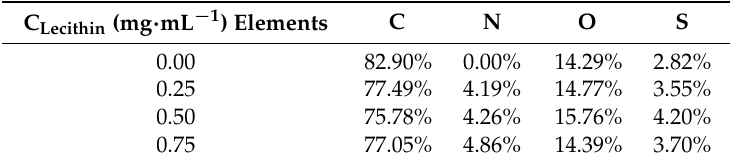
Figure 4. SEM image of blank PSF membrane (left) and the nitrogen distribution (measured by EDX) of the lecithin-modified PSF membrane with different concentrations of lecithin ( a – c ). Table 1. Analysis of elemental content of the lecithin-modified PSF membrane. (Mean value of three times measurements, the standard deviation was within 5%).